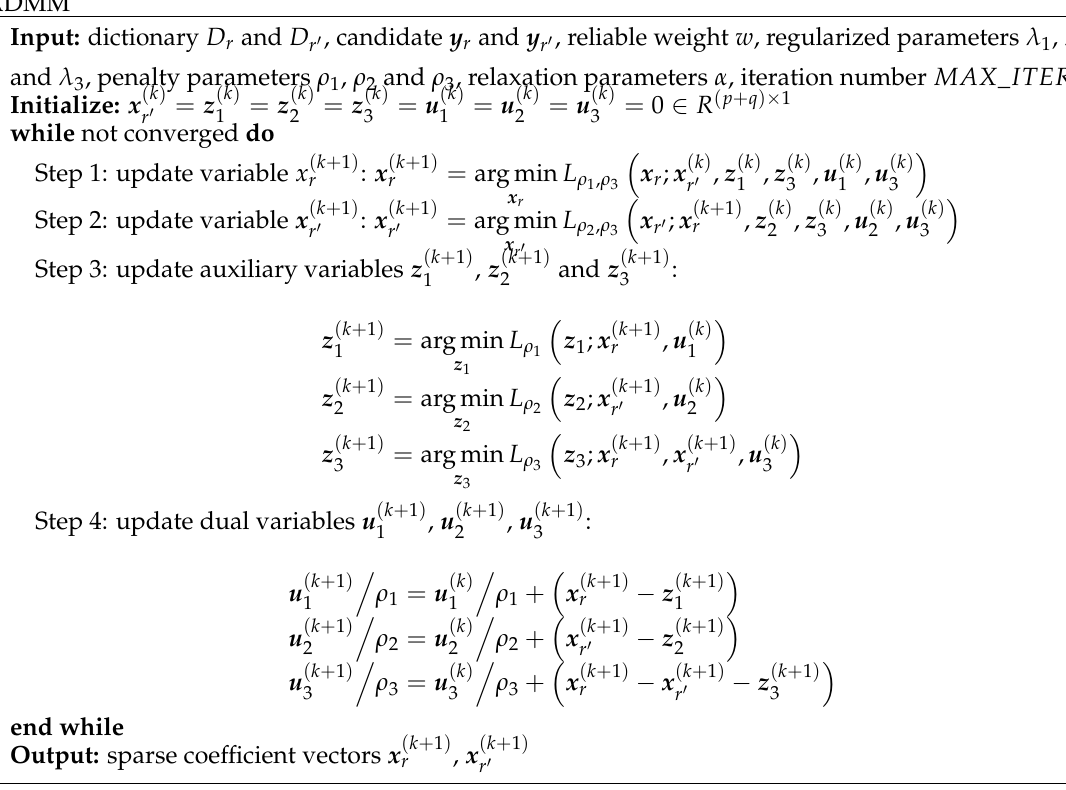
Algorithm 1 Optimization approach for solving the proposed mask sparse representation model via